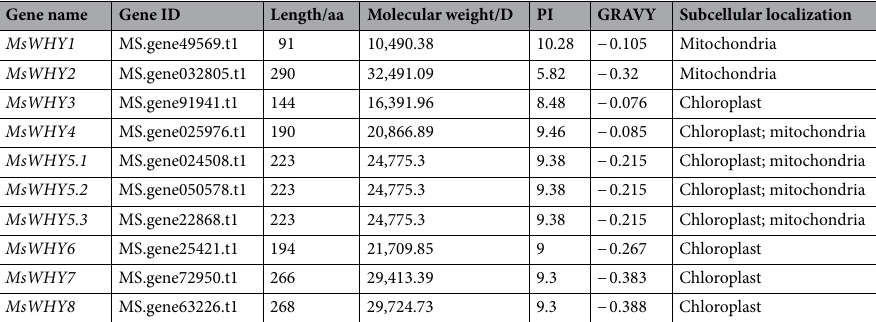
Table 1. Basic information about members of the Whirly gene family in alfalfa.